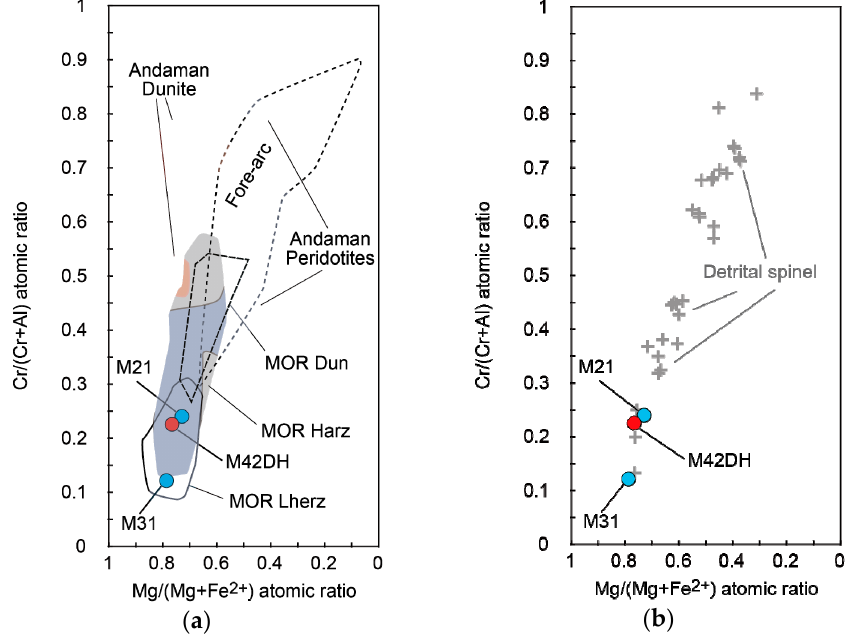
Figure 7. Relationship between the Mg# and Cr# of spinel. ( a ) Chemical comparison between the studied samples vs the compositional ranges for mid-ocean ridge lherzolite (MOR Lherz: solid line), harzburgite (MOR Harz: dark) and dunite (MOR Dun: broken line) [24], for forearc peridotites (broken line) compiled by [7] and for the Andaman dunites (pinkish) and Peridotites (light blue) are from [9]. ( b ) Chemical comparison between the studied sample and detrital chromian spinels from the Middle Andaman Island [11].